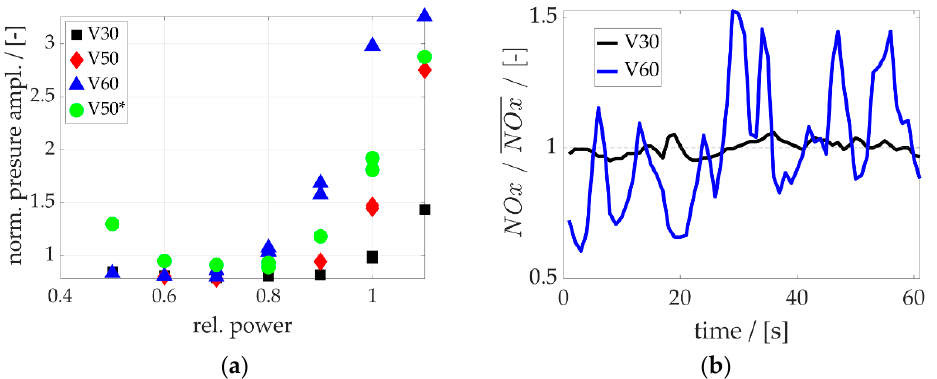
Figure 15. ( a ) Normalized acoustic pressure amplitudes with respect to the relative engine power for fluidic liquid-fuel nozzles of different spray opening angles (V30, V50, and V60) and flow numbers (V50 and V50*). ( b ) Fluctuation of the NO X emissions over time at stationary baseload conditions for nozzle variants V30 and V60 normalized with their respective mean value.